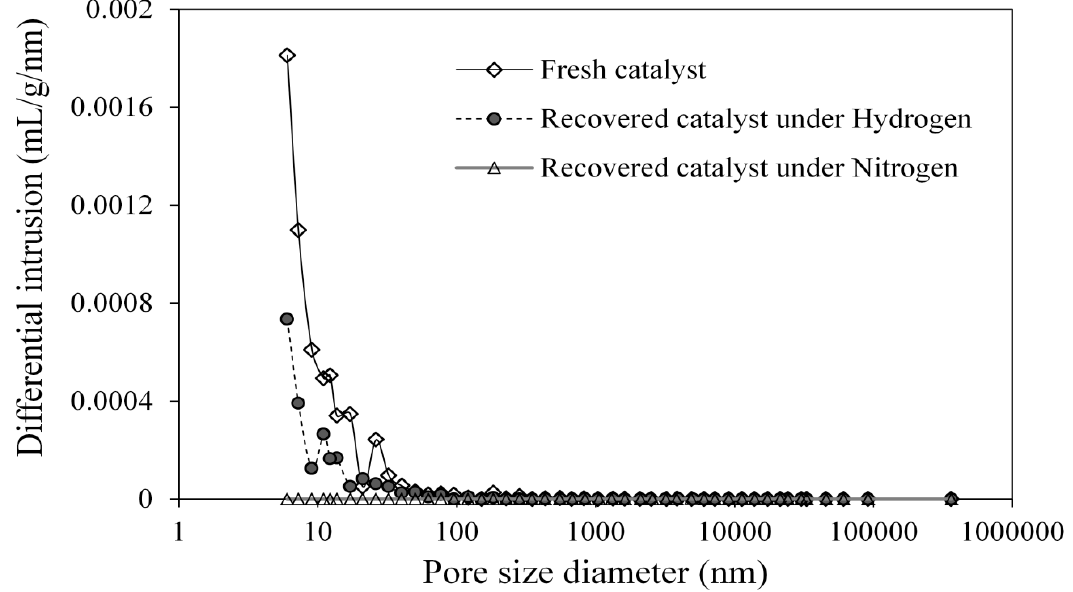
Figure 5. Mercury porosimetry of catalyst before and after experiment under N 2 and H 2 at 20 bar.